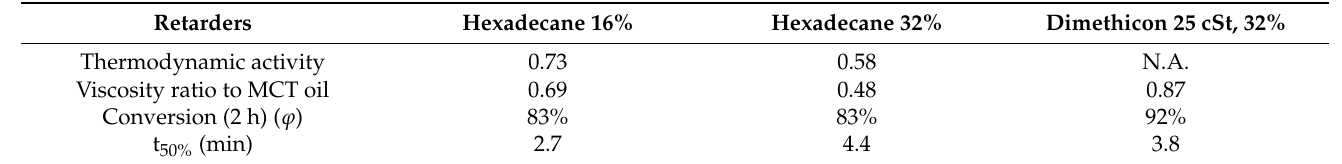
Table 4. Thermodynamic activity, final conversion (2 h), and the time point when reaching half final conversion (t 50% ) of hexadecane 16% and 32%, and dimethicon 25 cSt 32%.